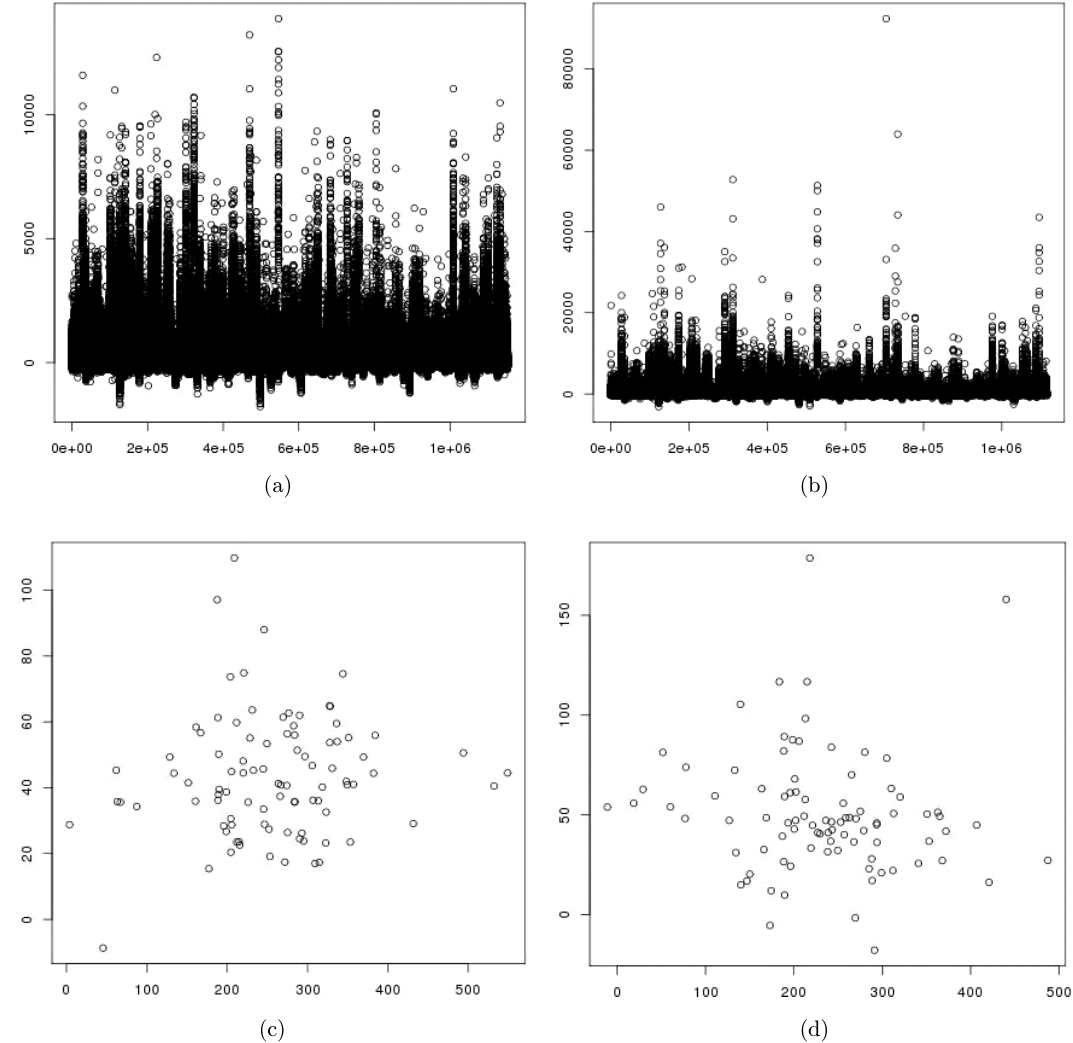
Fig. 8. Subtype of Cancers by GKFCM: (a) Gene expression in Cluster 1 (b) Gene expression in Cluster 2 (c) Cluster 1 in 181 Lung Cancer Dataset (d) Cluster 2 in 181 Lung Cancer